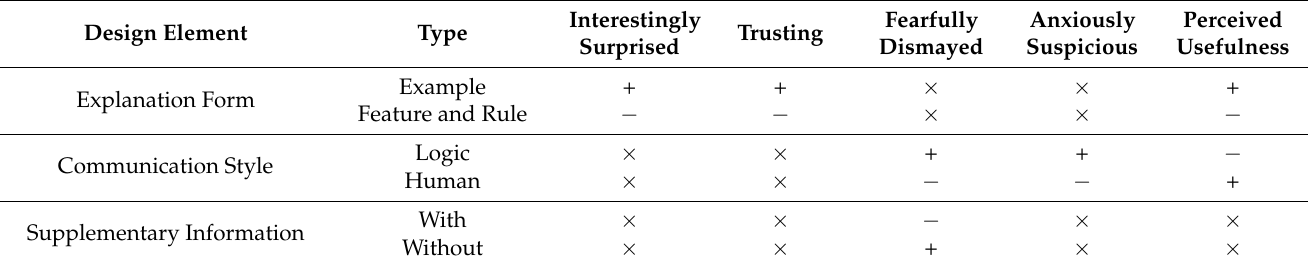
Table 13. Summary of affect and cognitive change per design